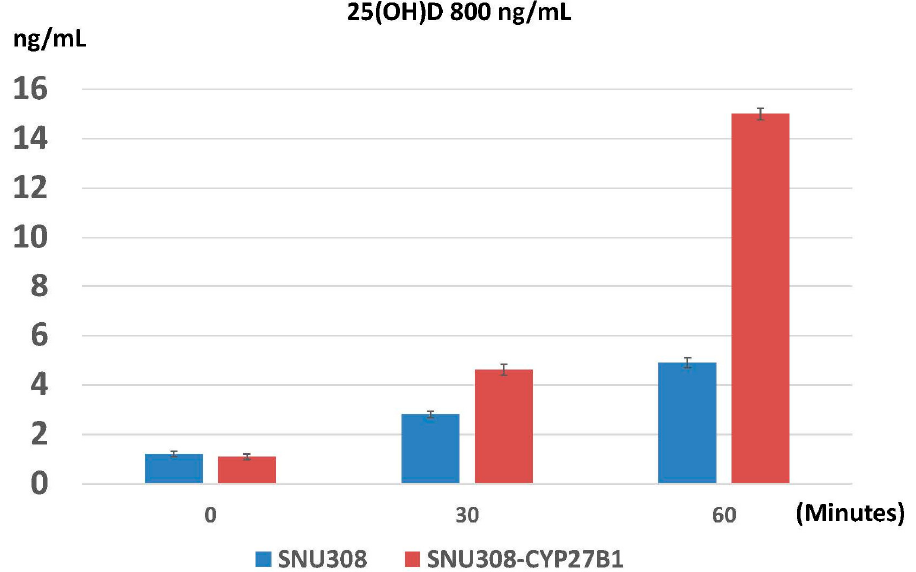
Figure 3. Evaluation of intracellular 1 α ,25(OH) 2 D 3 concentration after 25(OH)D treatment in SNU308 and SNU308-CYP27B1 cells. The intracellular 1 α ,25(OH) 2 D 3 concentrations of SNU308 and SNU308-CYP27B1 cells after 800 ng/mL 25(OH)D treatment were measured by ELISA at indicated time points. Each value is a mean ± SD of three to five determinations.